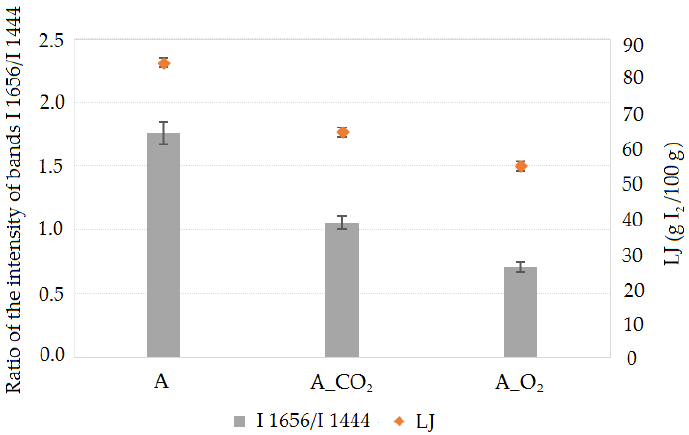
Figure 3. The influence of the A oil modification process on the fatty acids unsaturation change in A_CO 2 and A_O 2 oils, expressed by the I 1656 /I 1444 bands intensity ratio and LJ iodine number.